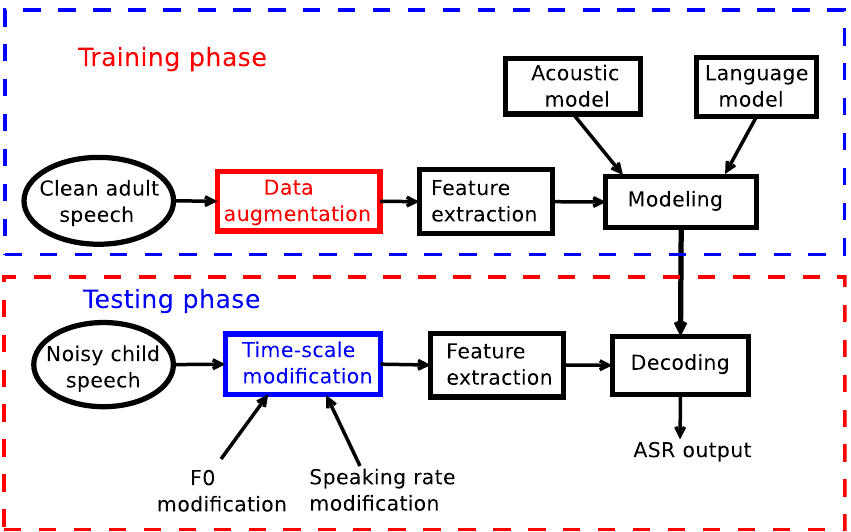
Figure 1. A flow diagram describing the ASR scenario studied in the current article to recognize noisy children’s speech using training based on clean adults’ speech. The two techniques studied, data augmentation and time-scale modification, are marked with red and blue color,